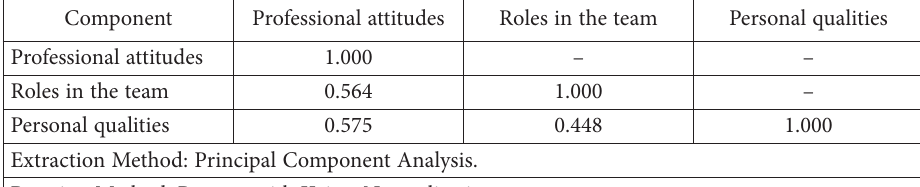
Table 1. Component correlation matrix of women’s participation in the innovation process of compa- nies (source: Author’s work, with SPSS use)